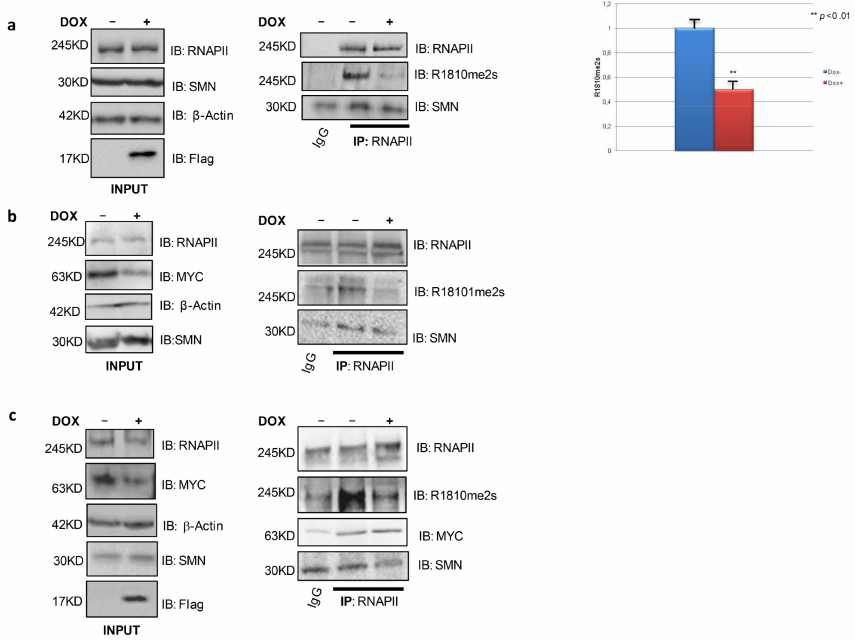
Figure 2. MYC inhibition by Omomyc and an shRNA against MYC affects RNAPII R1810 symmetrical dimethylation in cancer cells. Cells were treated with doxycycline for 24 h. Thereafter, immunopre- cipitation was performed by means of an anti-RNAPII antibody, followed by immunoblotting with anti-RNAPII-R1810me2s, MYC, SMN, and RNAPII antibodies. ( a ) BT168FO cells. R1810 symmetrical dimethylation was severely impaired in the presence of FlagOmomyc. SMN binding to RNAPII also decreased. ( b ) BT168 cells infected with a lentivirus encoding a doxycycline-inducible shRNA against MYC. The shRNA strongly decreased RNAPII symmetrical dimethylation and SMN recruitment. ( c ) RamosFO cells. Also in this cancer cell line, MYC inhibition led to a decrease in RNAPII symmetri- cal dimethylation and SMN recruitment. Densitometry histograms are shown to the right of each panel. Each bar represents mean ±